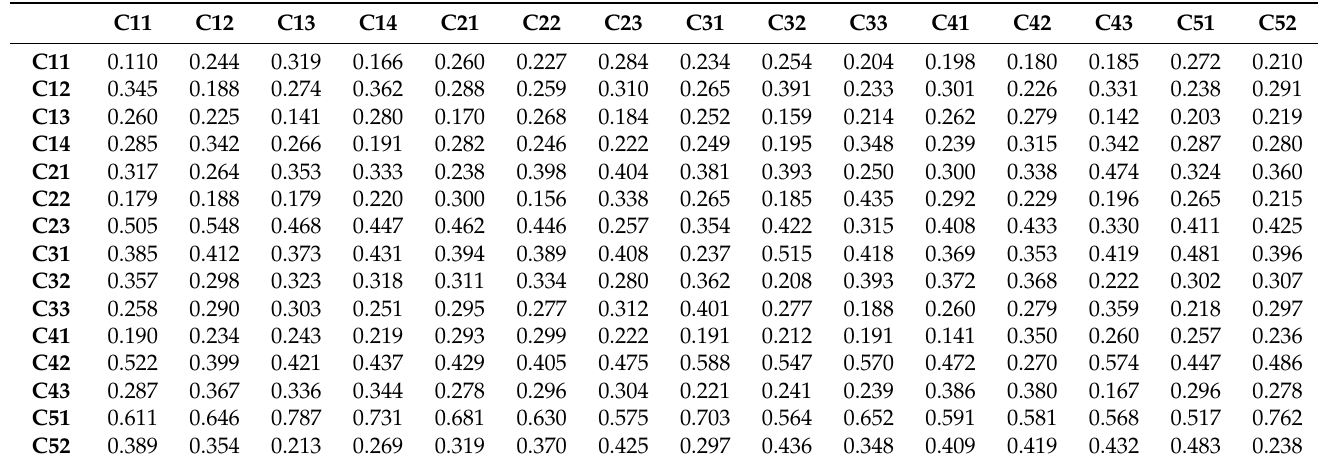
Table A10. Unweighted matrix in the present investigation.